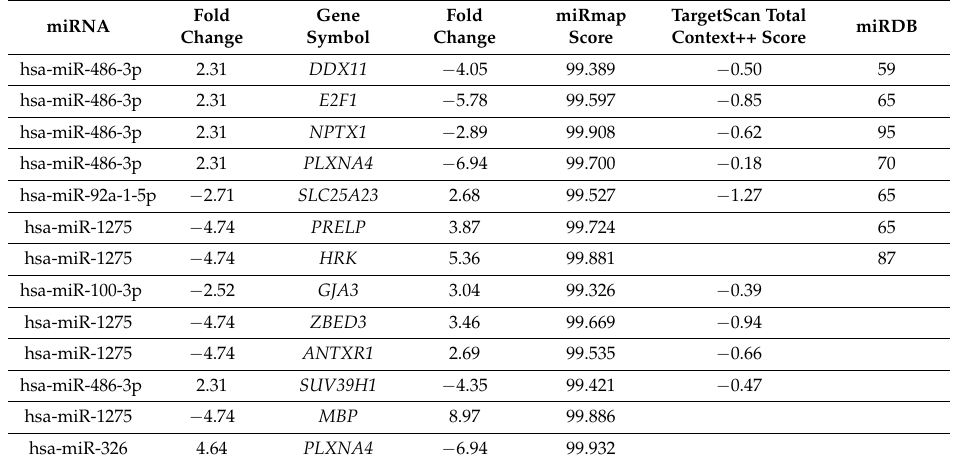
Figure 6. Identification of dysregulated genes with potential miRNA–mRNA interactions in nintedanib-treated IPF fibroblasts. The Venn diagram analysis of predicted targets of dysregulated miRNAs and dysregulated mRNAs identified 7 upregulated genes and 5 downregulated genes with potential miRNA–mRNA interactions. Table 1. Potential miRNA–mRNA interactions associated with nintedanib treatment validated with miRmap, TargetScan and miRDB.